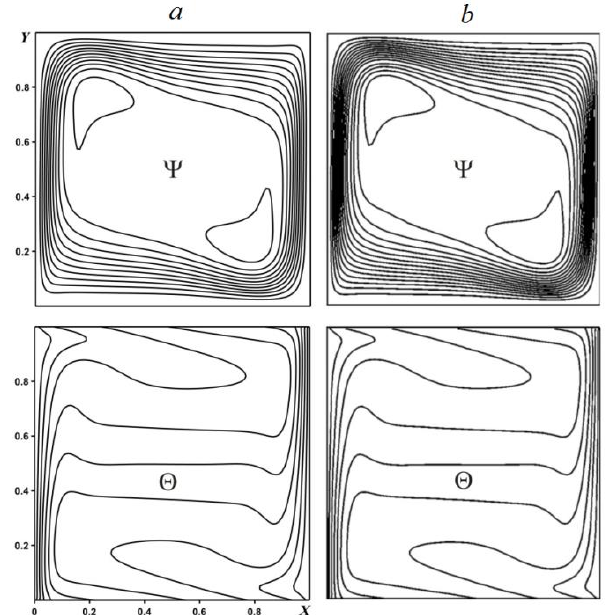
Figure 2. ( a ) Streamlines Ψ and isotherms Θ at Ra = 10 6 , (cid:101) (cid:101) = 0.8 ( b ) numerical data of Wang et al. [27]. Energies 2019 , 12 , x FOR PEER REVIEW 7 of 15